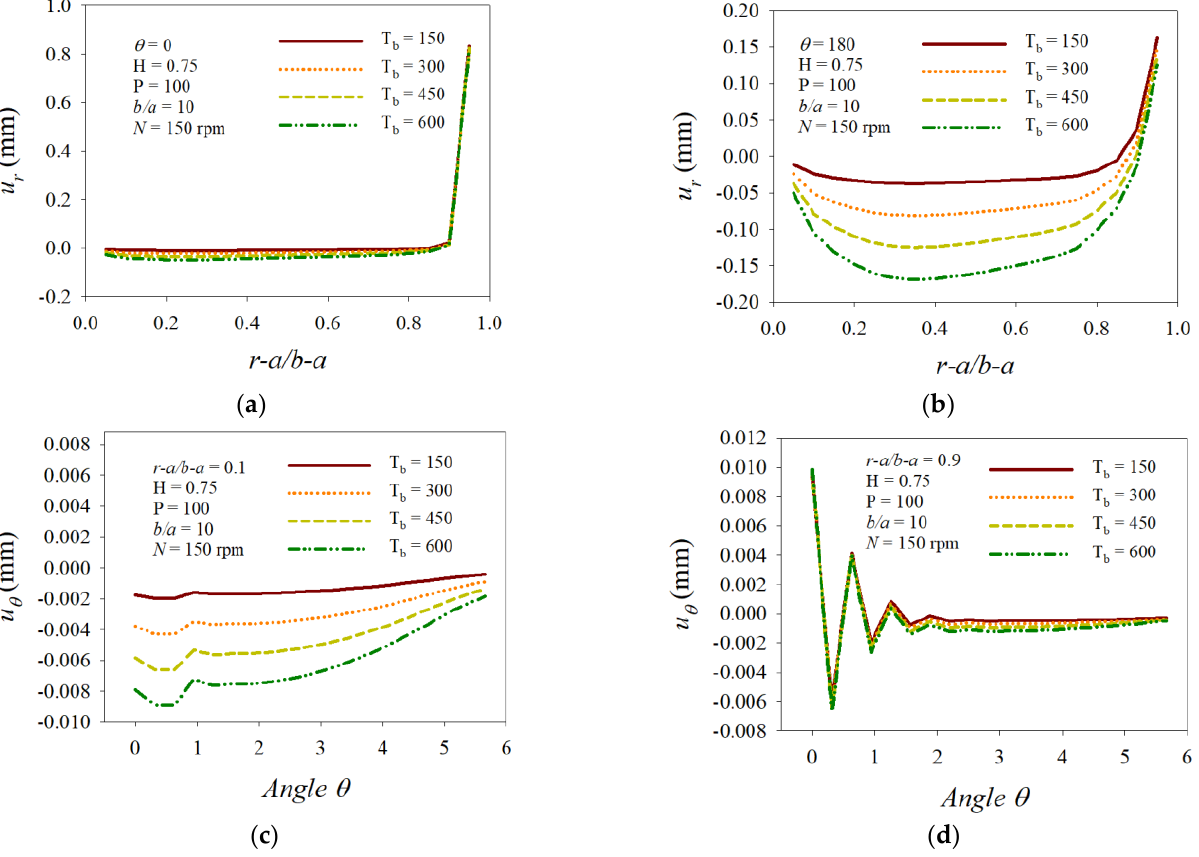
Figure 4. Effects of outer boundary temperature on the components of displacement: ( a ) Radial at θ = 0 , ( b ) radial at θ = 180 , ( c ) circumferential at (r − a)/(b − a) = 0.1, ( d ) circumferential at (r − a)/(b − a) = 0.9.